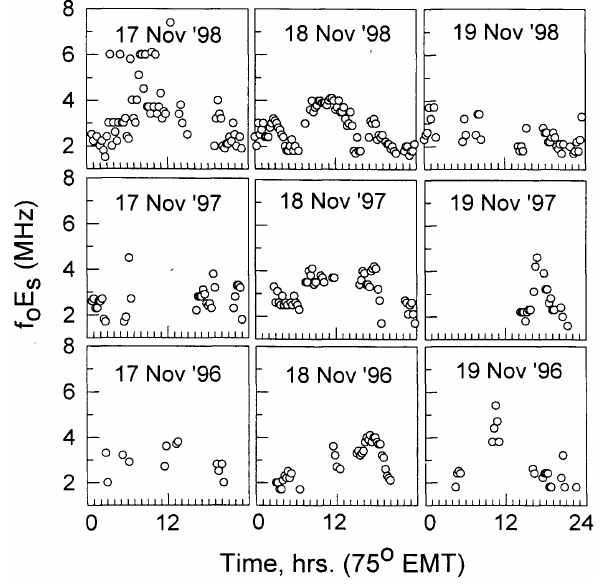
Fig. 4. Daily variations of f b E s over Ahmedabad for the period 17 to 19 November for the years 1996–98 based on hourly data for 1996–97 and quarter hourly data for